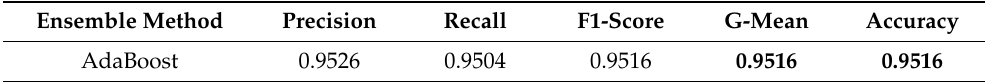
Table 5. Performance of the AdaBoost Ensemble